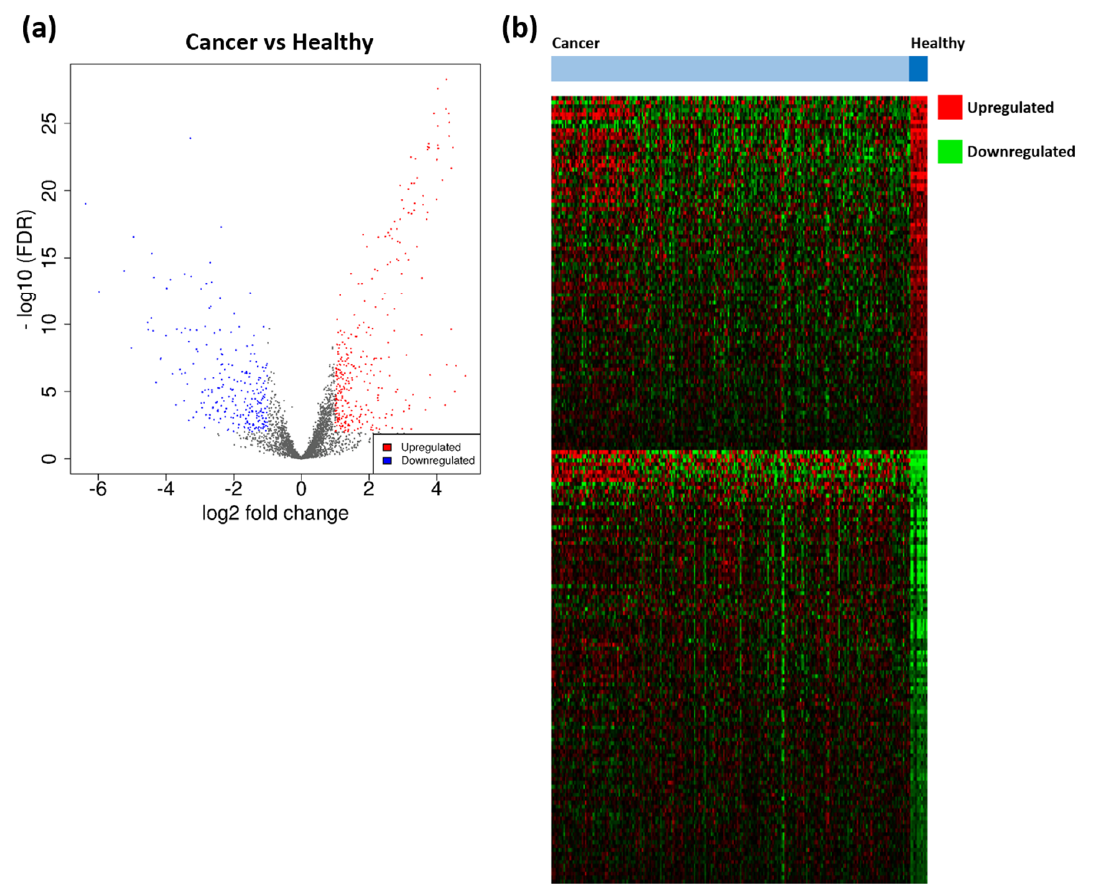
Figure 3. Differentially expressed genes (DEGs) identified between endometrial cancer (EC) and healthy endometrium. ( a ) Volcano plot of DEGs amongst cancer ( n = 234) and healthy samples ( n = 11). Significant DEGs are coloured; red dots represent upregulated genes, and blue dots represent downregulated genes. Cut-off criteria: │ log2FC > 1 │ and false discovery rate (FDR) < 0.01. ( b ) Heatmap displaying the expression of 568 DEGs. Red denotes upregulated genes and green denotes downregulated genes.